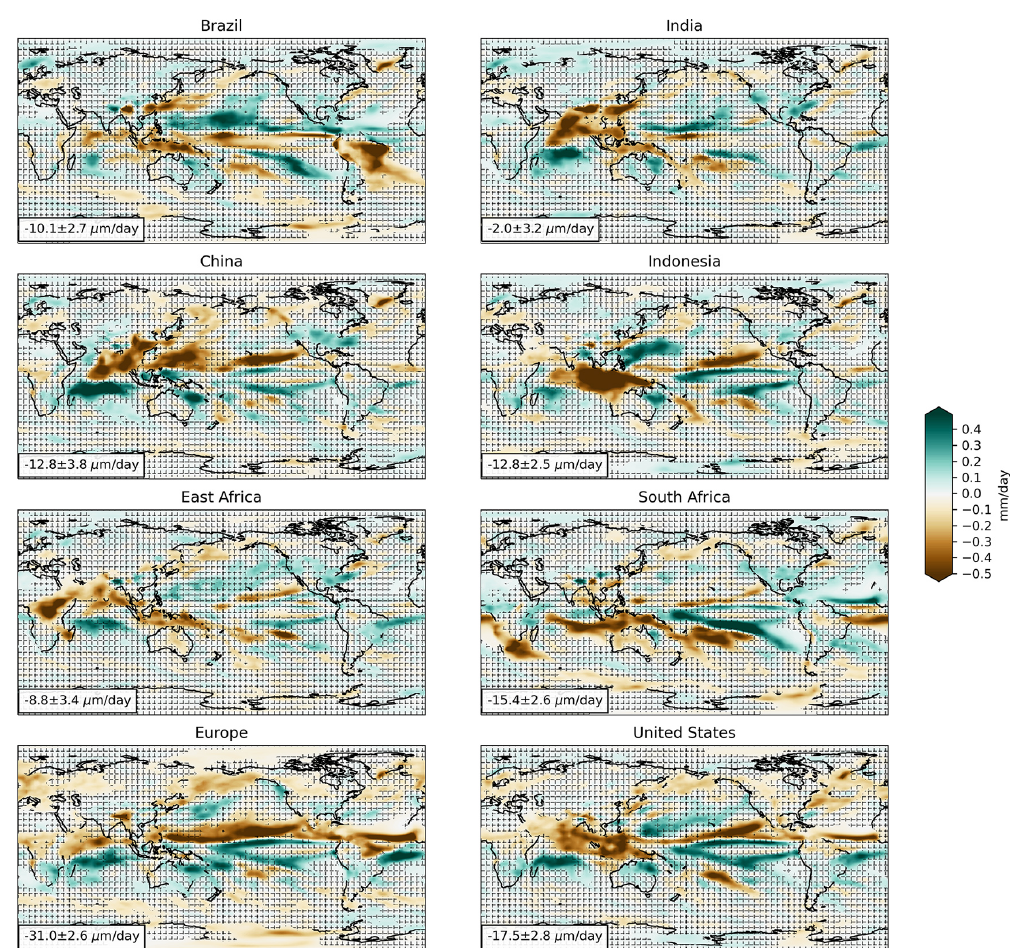
Figure A2. As in Fig. 1 but for the second simulation set conducted with adjusted initial conditions (see Sect. 2).